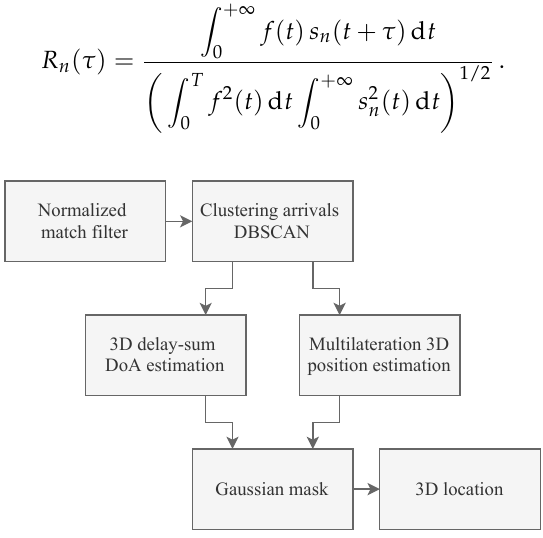
Figure 1. Flow diagram of the DoA estimation and localization